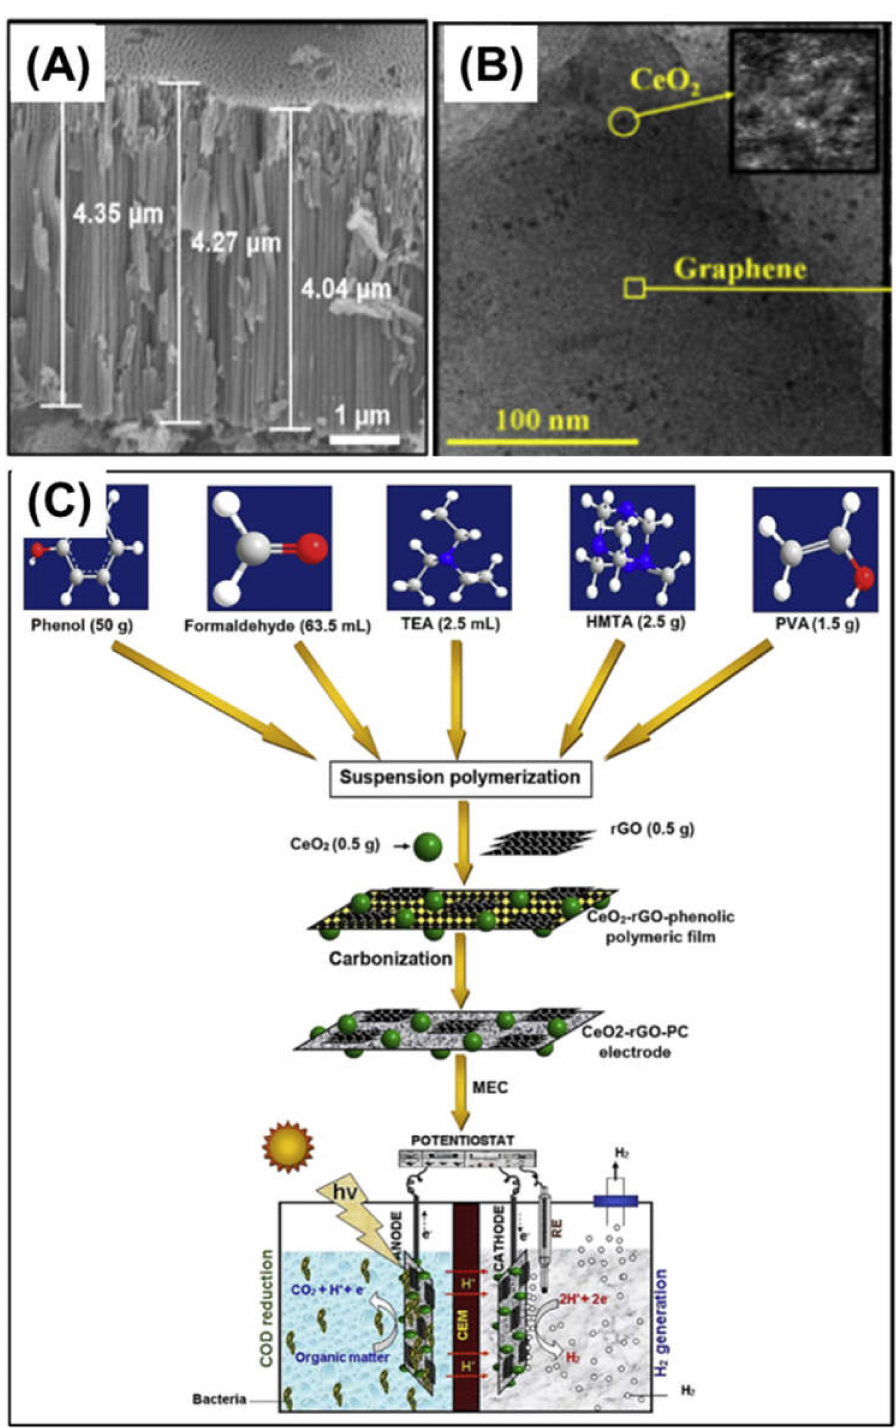
Figure 4. Nanomaterials applied to anode electrodes of MECs: ( A ) photocatalytic TiO 2 nanotube array anode electrode. Reprinted with permission from Ref. [27]. Copyright MDPI 2018, ( B ) CeO 2 nanoparticle-decorated rGO nanosheets. Reprinted with permission from Ref. [38]. Copyright Elsevier 2020, and ( C ) fabrication procedure for CeO 2 –rGO-incorporated carbon film anode electrode. Reprinted with permission from Ref. [38]. Copyright Elsevier